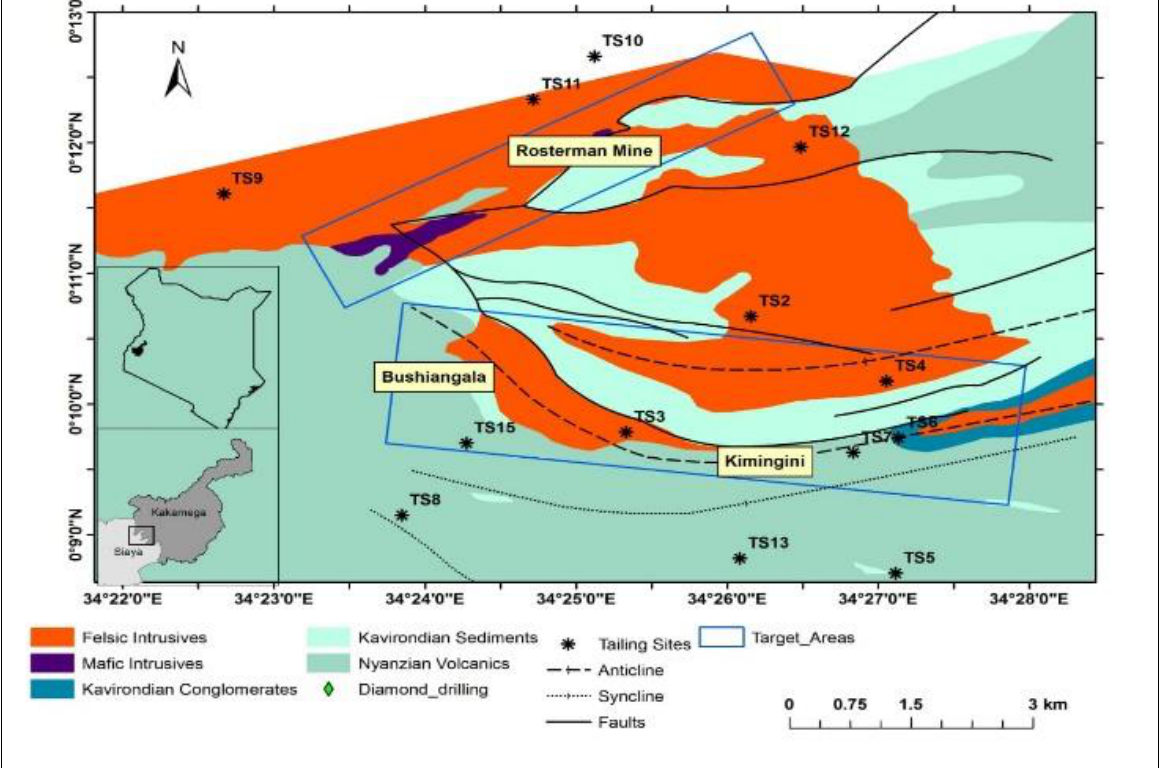
Figure 2: Sampling Points at the Study Area. Source: